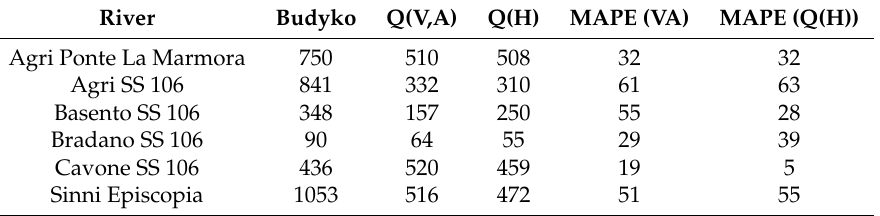
Table 7. Comparison of the mean annual volume of discharges obtained using the extracted flow-rating curves with the two proposed approaches and the expected volumes obtained using the Budyko model for